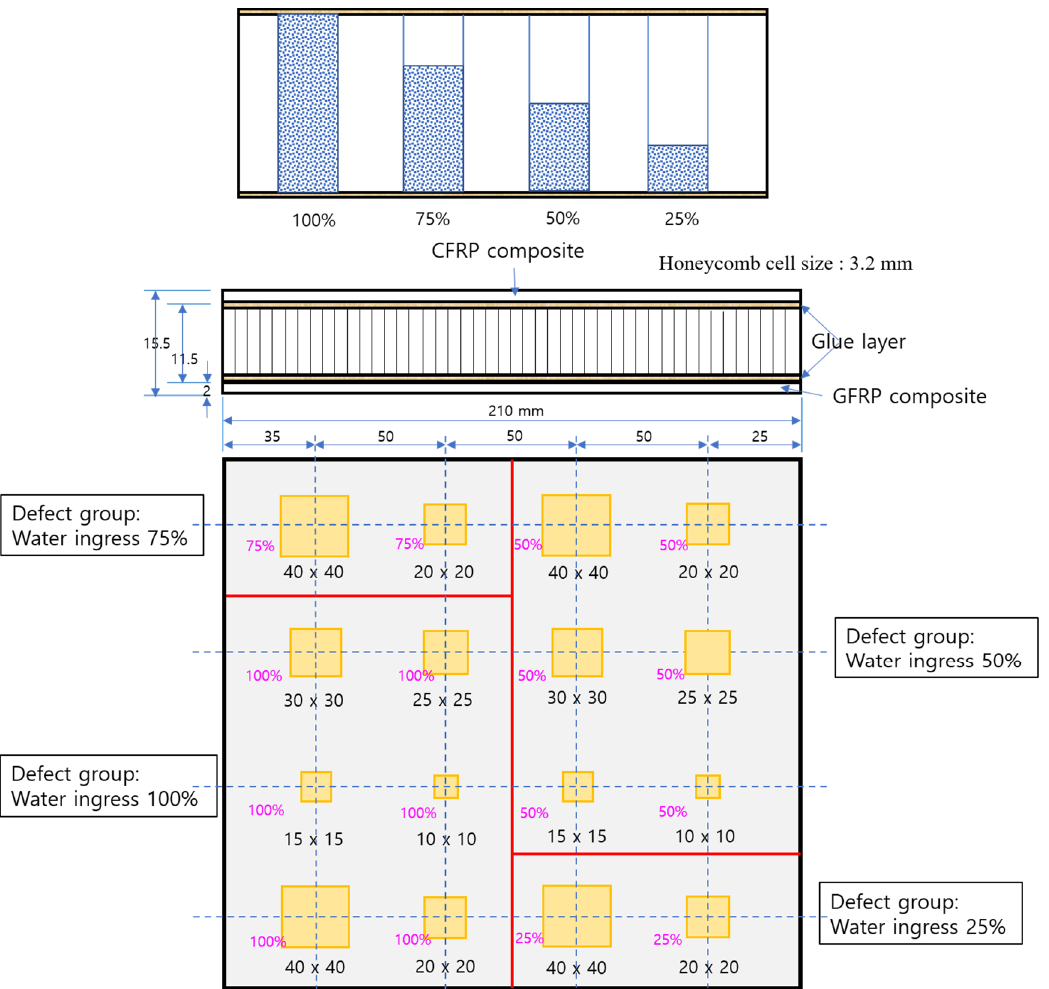
Figure 2. Schematic of the honeycomb-cored sandwich panel considering various water ingress conditions.